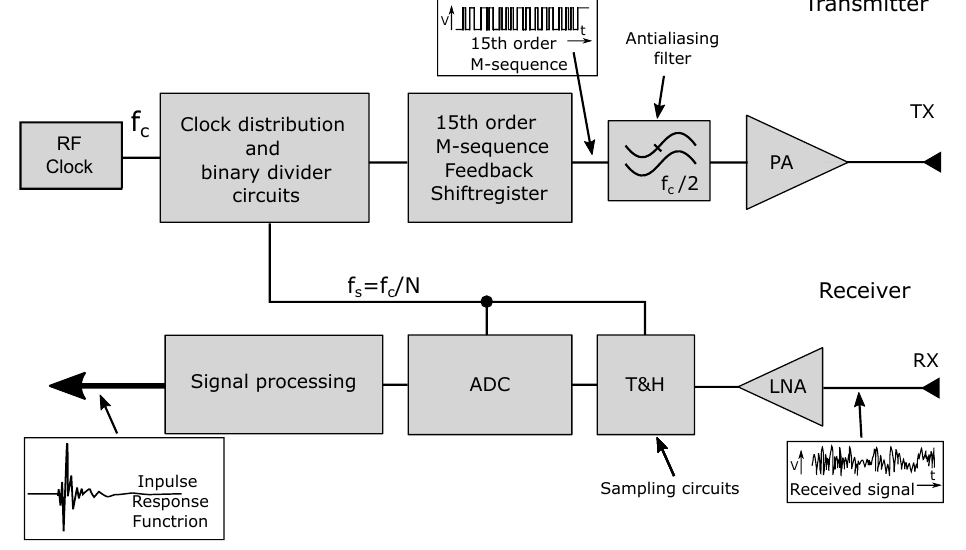
Figure 2. Block diagram of the M-sequence radar.